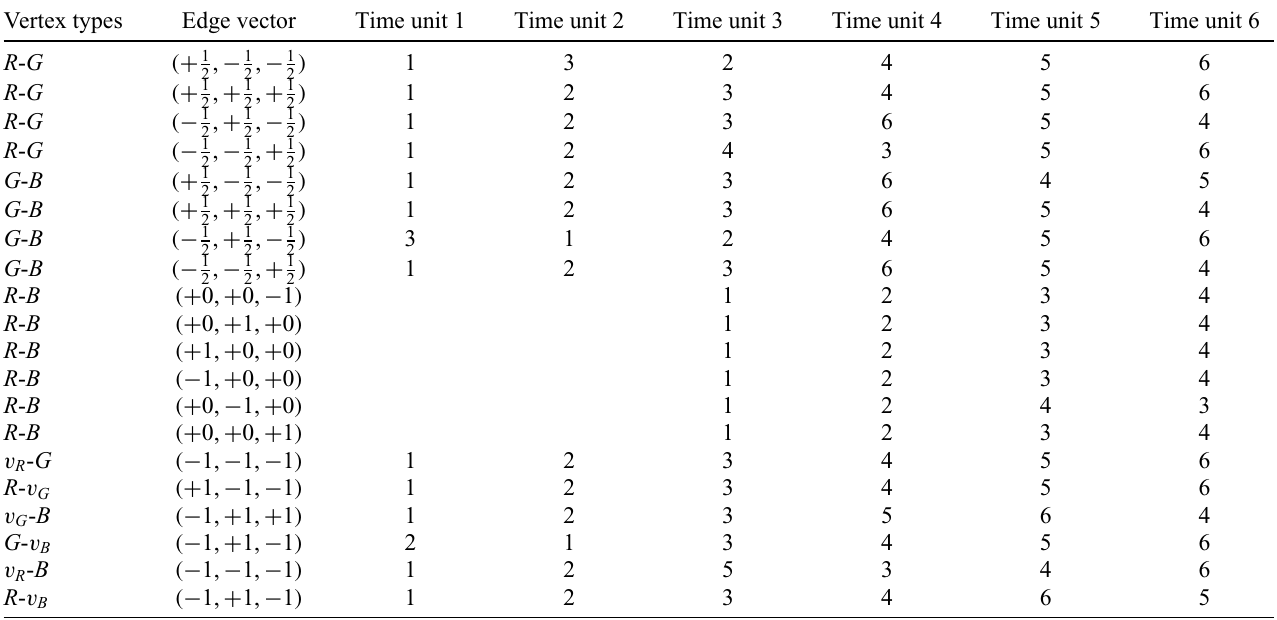
TABLE VI. Measurement circuit specification for RG , RB , and GB gauge operators. Edges connecting interior vertices (first 14 rows) are labeled by the vertex colors (first column) and the vector connecting them (second column). Edges connecting a boundary vertex are labeled by that boundary vertex v R , v G , or v B and the color of the interior vertex. Qubits around an edge are labeled in order of increasing azimuthal angle, and the column in which each data qubit appears specifies which time unit a CNOT occurs from that data qubit to the corresponding measurement qubit for the